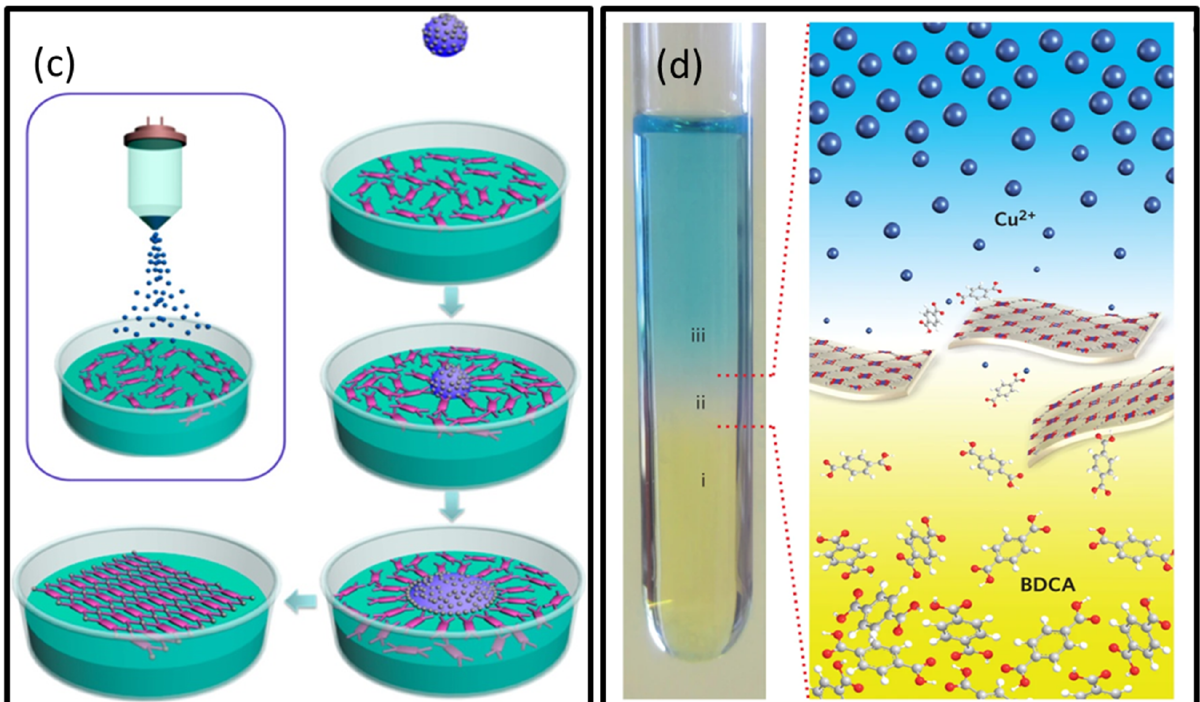
Figure 6. Schematic illustrations of different interfacial methods employed for the synthesis of 2D MOFs: ( a ) Formation of a single-layer sheet of Ni-based MOF at a liquid-air interface by Langmuir-Blodgett method. Reproduced from [69] Copyright 2015 Wiley Materials. ( b ) Synthesis of 2D Fe-MOF at a liquid-solid interface. Reprinted (adapted) with permission from [70]. Copyright 2017 American Chemical Society. ( c ) Formation of MOF nanosheets at a liquid-liquid interface by spraying technique. Reprinted (adapted) with permission from [68]. Copyright 2017 American Chemical Society. ( d ) Formation of ultrathin nanosheets of CuBDC MOF by a three-layer preparation approach. Reprinted by permission from [Springer Nature Customer Service Centre GmbH]: [Springer Nature] [Nature Materials] [Metal ‐ organic framework nanosheets in polymer composite materials separation, Tania Rodenas et al.] [Copyright 2014 Macmillan Publishers Limited] (2015)